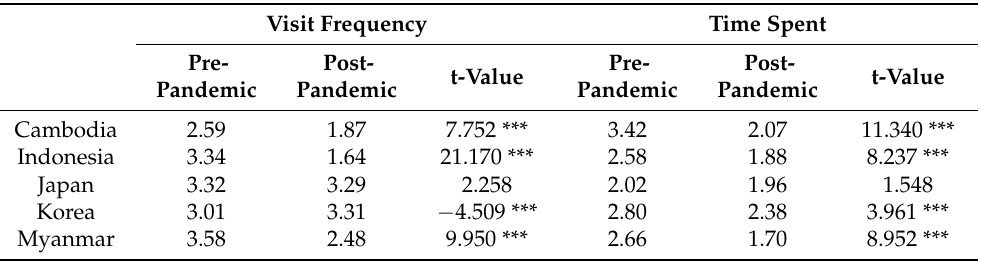
Table 3. Pre- and post-pandemic comparison of visit frequency and time spent in the forest and natural environment (mean values).